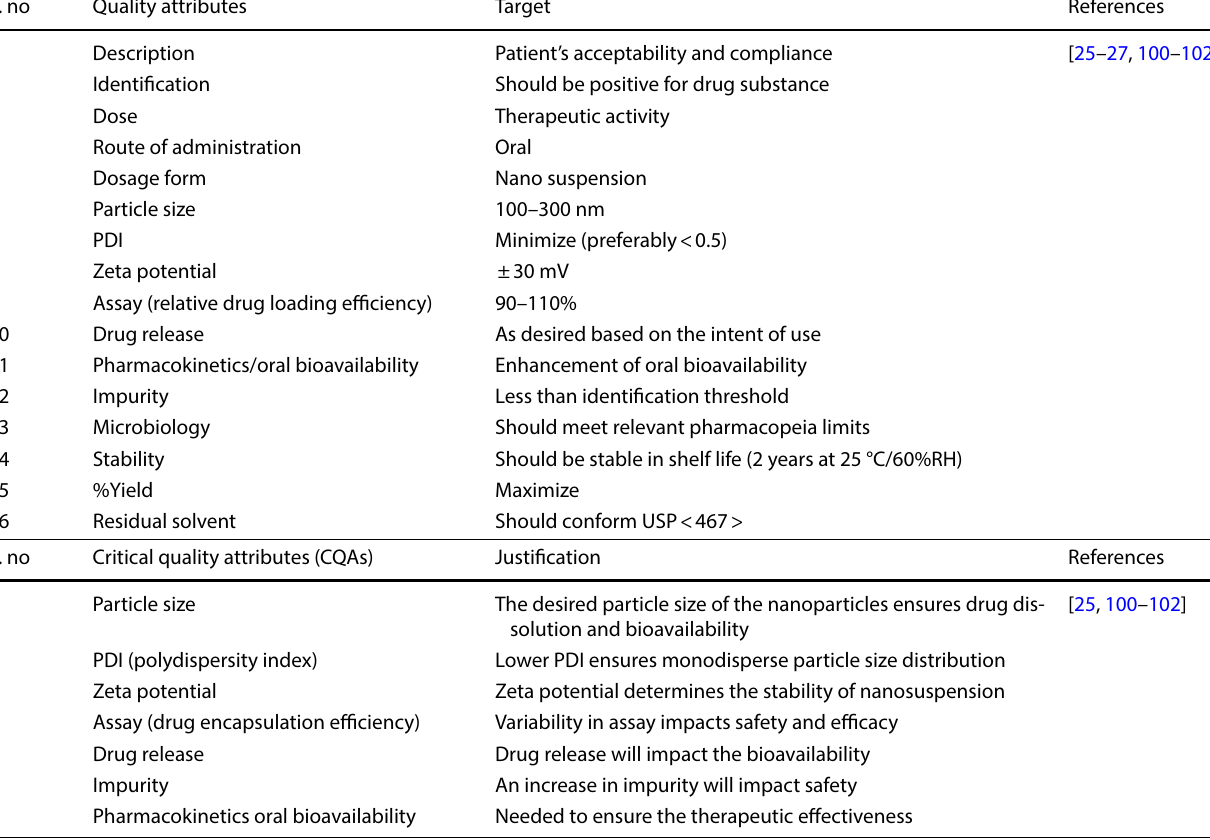
Table 2 Few selected QTPP and CQAs for PLGA nanosuspension by double emulsion (W/O/W)